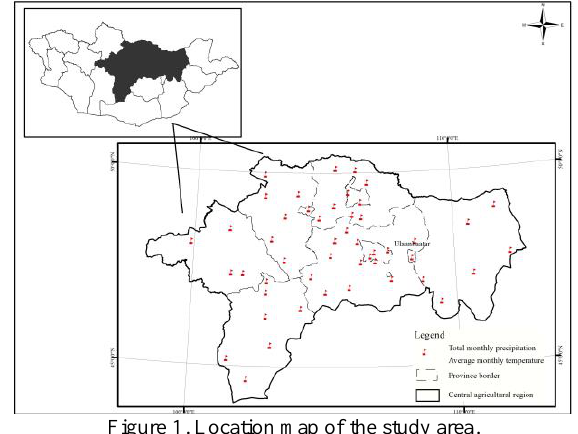
Figure 1. Location map of the study area.